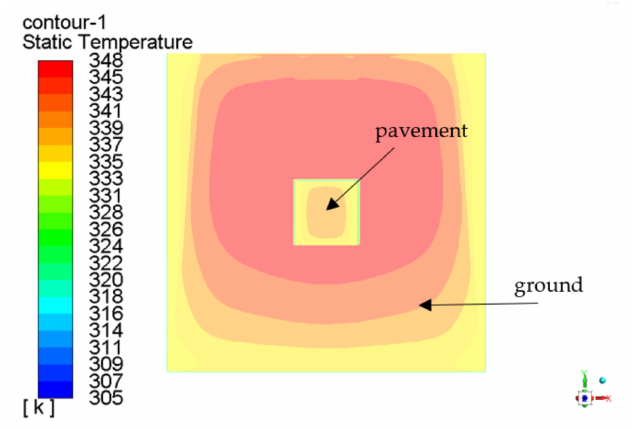
Figure 6. Temperature profile with asphalt albedo value of 0.1.